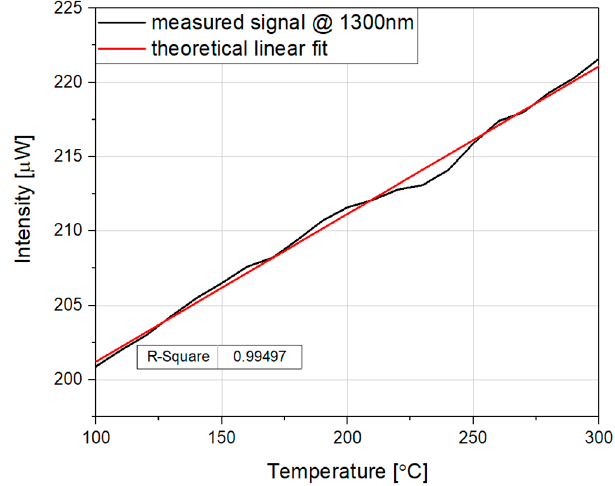
Figure 5. Dependence of the reflected signal peak intensity vs. temperature for a microsphere-based sensor with 200 nm ZnO ALD coating, measured at a wavelength of 1300 nm. A theoretical linear fit is also included.